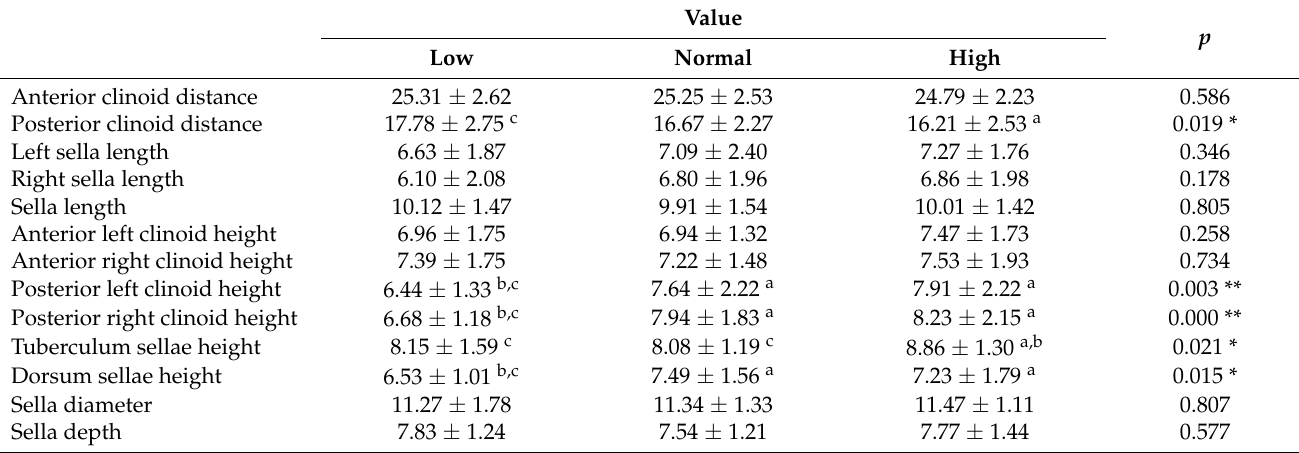
Table 4. Differences in sella turcica dimensions among three groups.